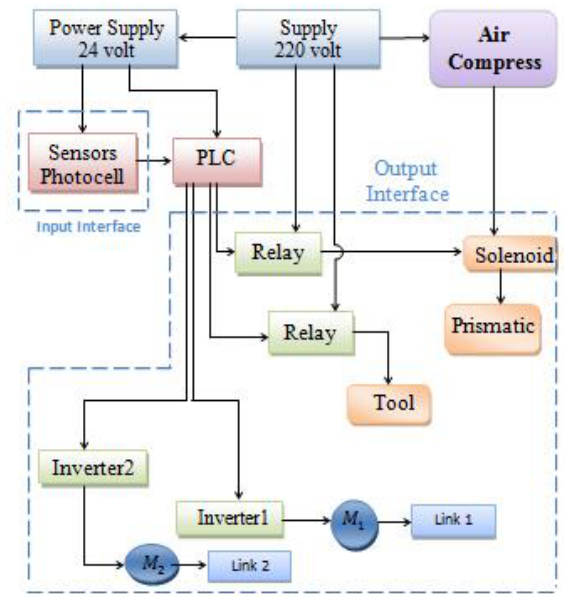
Fig. 13. The Schematic Block Diagram for Overall System .